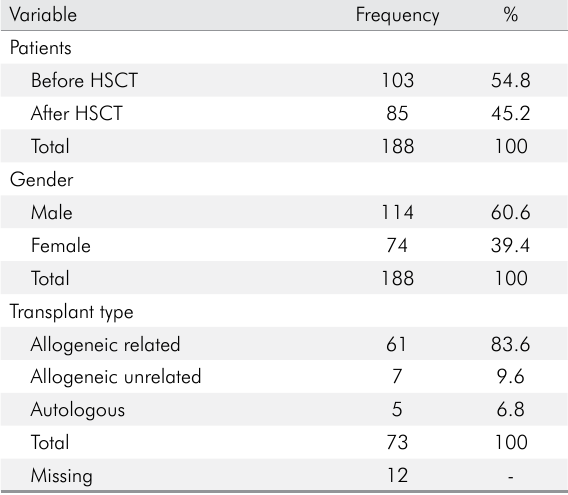
Table 1. Description of the patients’ characteristics. Variable